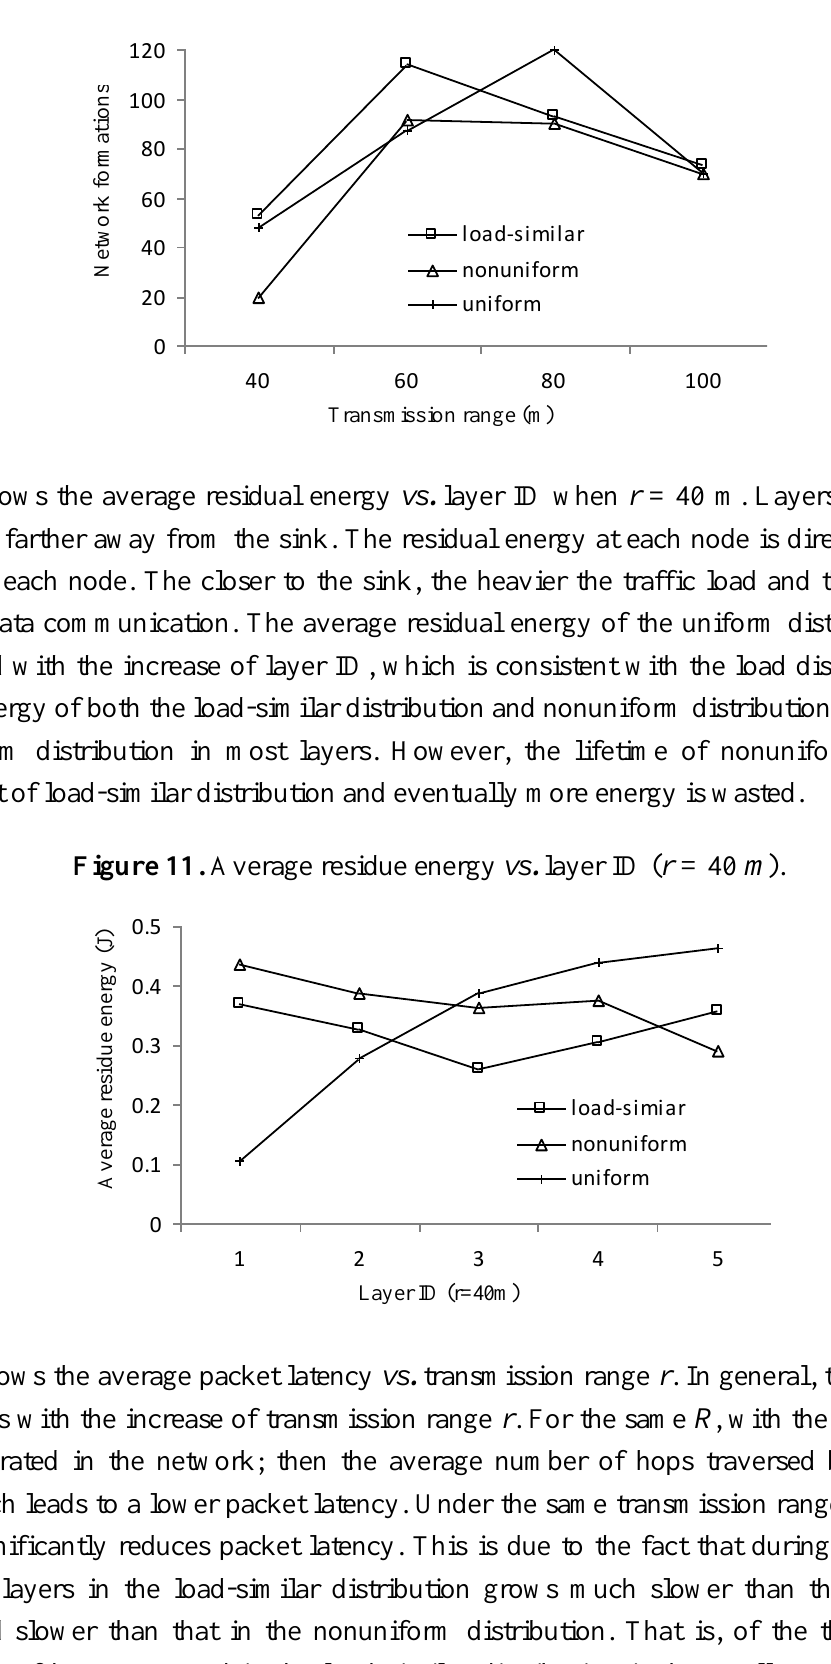
Figure 10. Number of network formations vs. r .